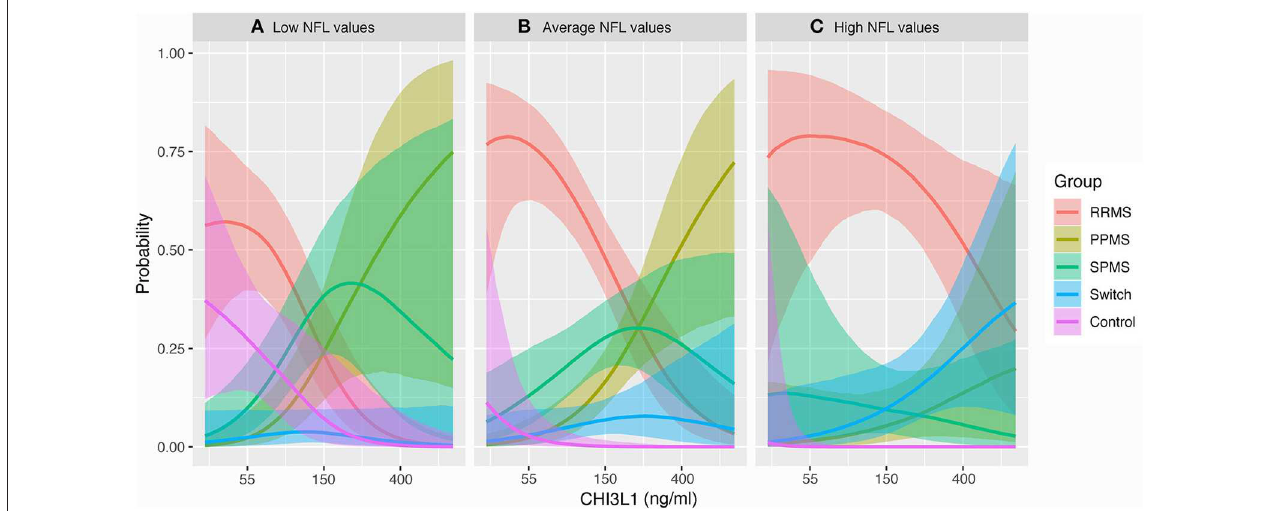
FIGURE 5 | Marginal effect plots. This plot is the graphical representation of the multinomial regression model performed and shows the probability to be comprised in a MS clinical form, including the probability of conversion to SPMS, with regards to CSF NFL, and CHI3L1 levels. Thus, this diagram shows the interaction between both biomarkers. (A) When levels of NFL are low, low CHI3L1 levels imply higher probability to be a non-MS control (pink) or a RRMS patient (red). High CHI3L1 levels in these patients are associated with the diagnosis of progressive MS (green and brownish green). Probability of switching to SPMS is very low. (B) With average levels of NFL, the probability of pertaining to a non-MS control decreases, and CHI3L1 levels discriminate better between RRMS (low CHI3L1), and PPMS (high CHI3L1). (C) With high NFL levels, the probability of being comprised in the RRMS group is the highest. High NFL and CHI3L1 are more probable in patients diagnosed of SPMS during follow-up, and in a subgroup of PPMS patients, likely PPMS patients with active disease. NFL, neurofilament light chain; CHI3L1, chitinase-3-like-1; RRMS, relapsing-remitting multiple sclerosis; SPMS, secondary progressive multiple sclerosis; PPMS, primary progressive multiple sclerosis; Switch, diagnosis of SPMS during